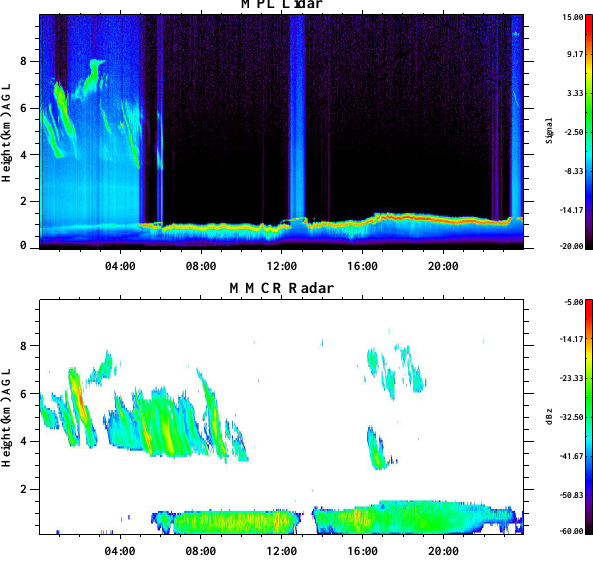
Fig. 14. Lidar and radar returns from NSA-AAO on 13 January,